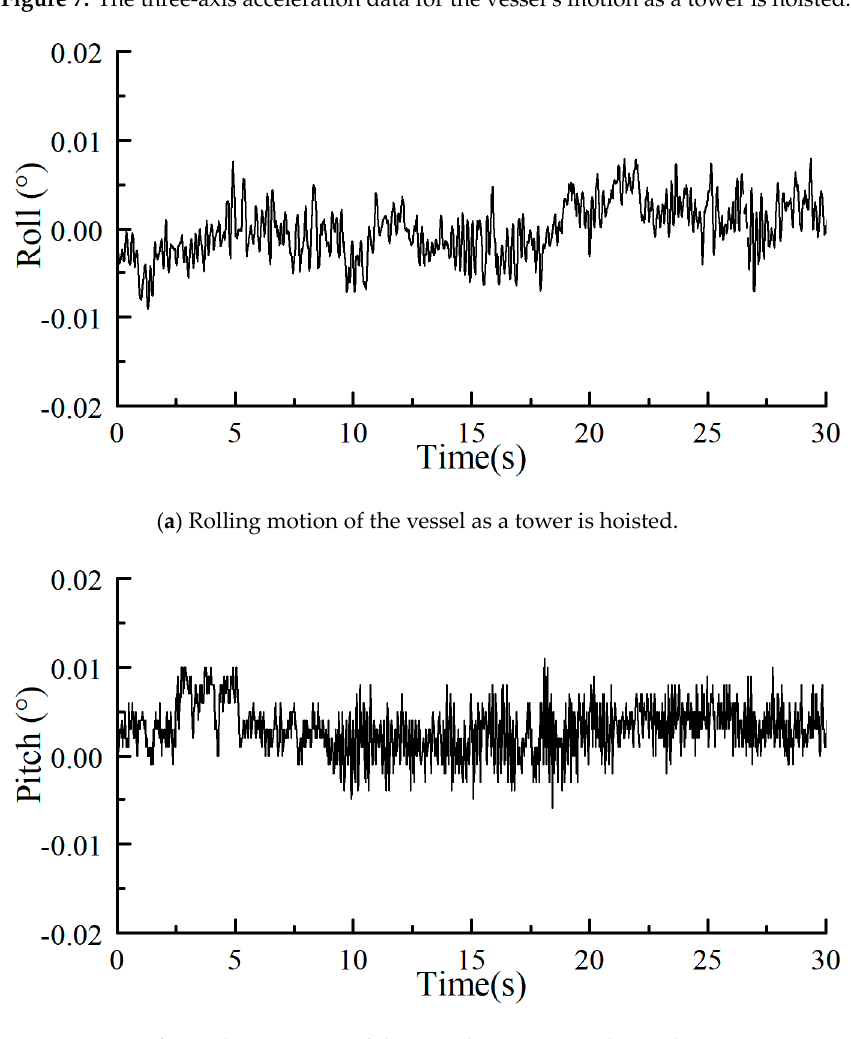
Figure 8. The roll and pitch angles of the vessel as a tower is hoisted.